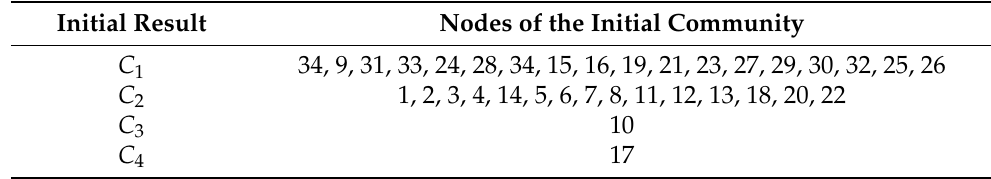
Table 3. The initial community structure of